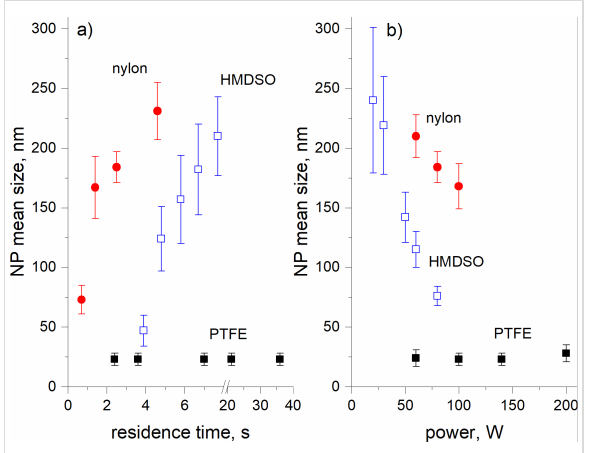
Figure 9: Mean diameter of nylon-sputtered, PTFE-sputtered and HMDSO plasma polymer NPs as a function of a) the residence time and b) the power of the discharge. The data are calculated from the results presented in [53,54,67].